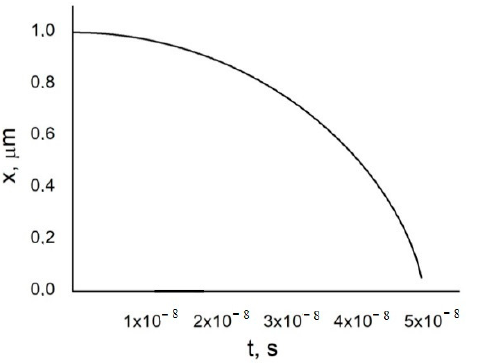
Figure 3. The process of pressing ME weighing 2 × 10 − 13 kg from a distance of 1 µ m. V = 300 V; ferroelectric material parameters: ε = 1000 and d = 1 µ m.